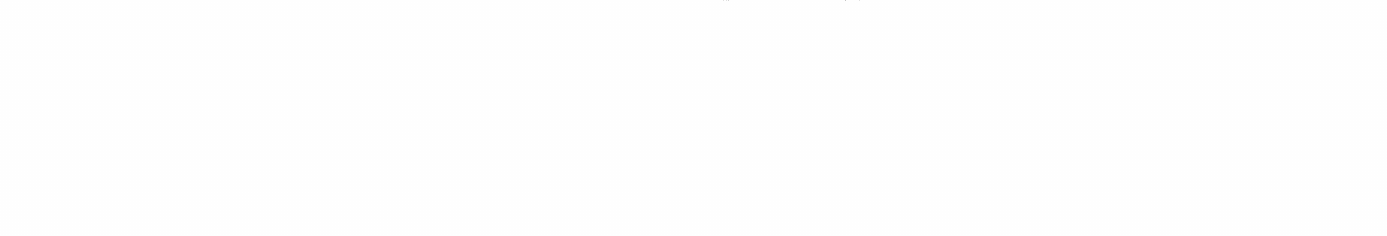
FIGURE 5 The funnel filling levels x, x and x3 as a function of time. The sum of these values is constant. The markers denote the discrete time. Note that the switching takes place if one of the variables xi becomes negative or